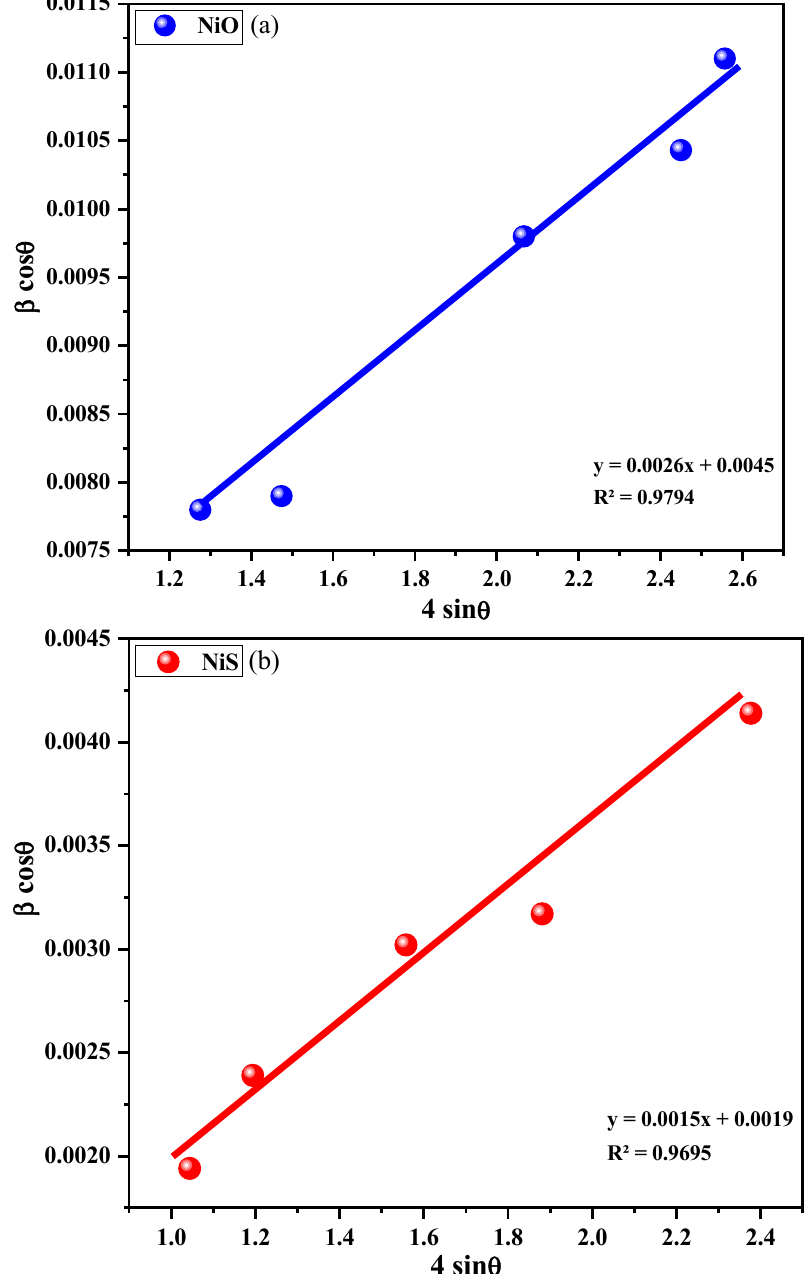
Figure 11. William–Hall plots for ( a ) NiO and ( b )